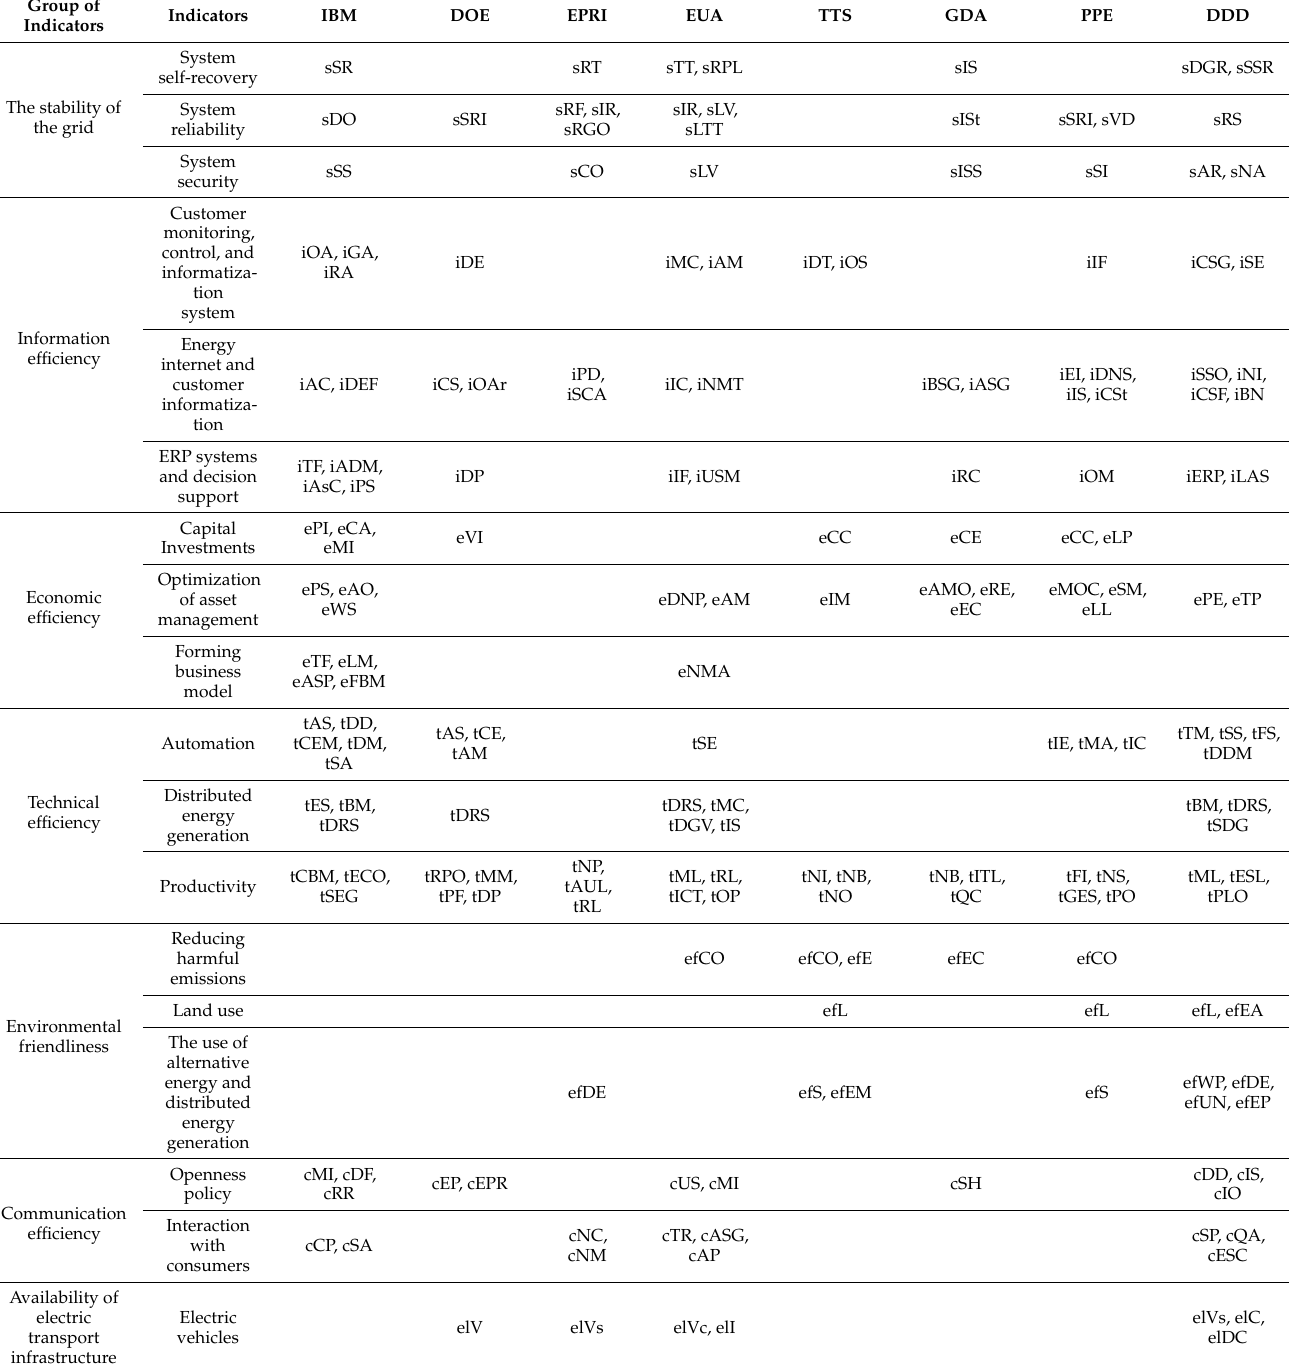
Table 2. Distribution of indicators of existing comprehensive assessment systems in certain areas of smart